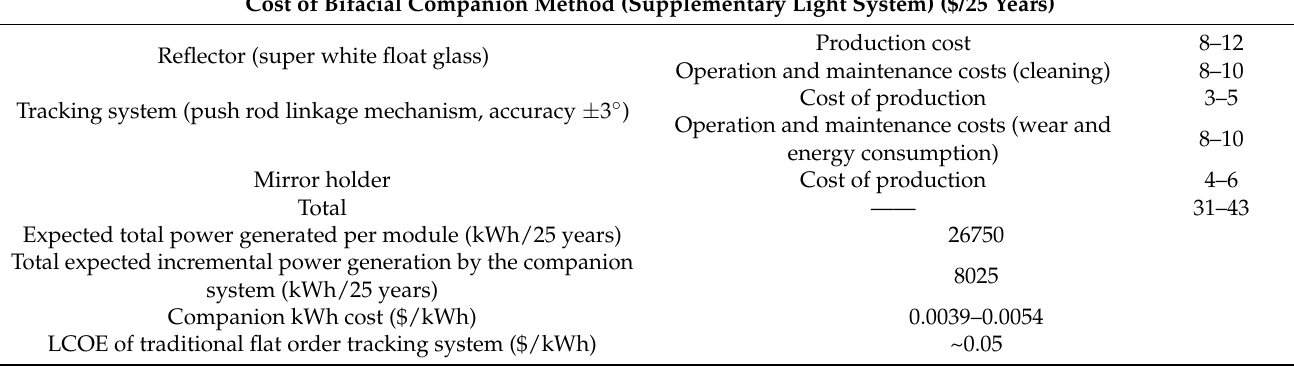
Table 5. Cost analysis of the bifacial companion